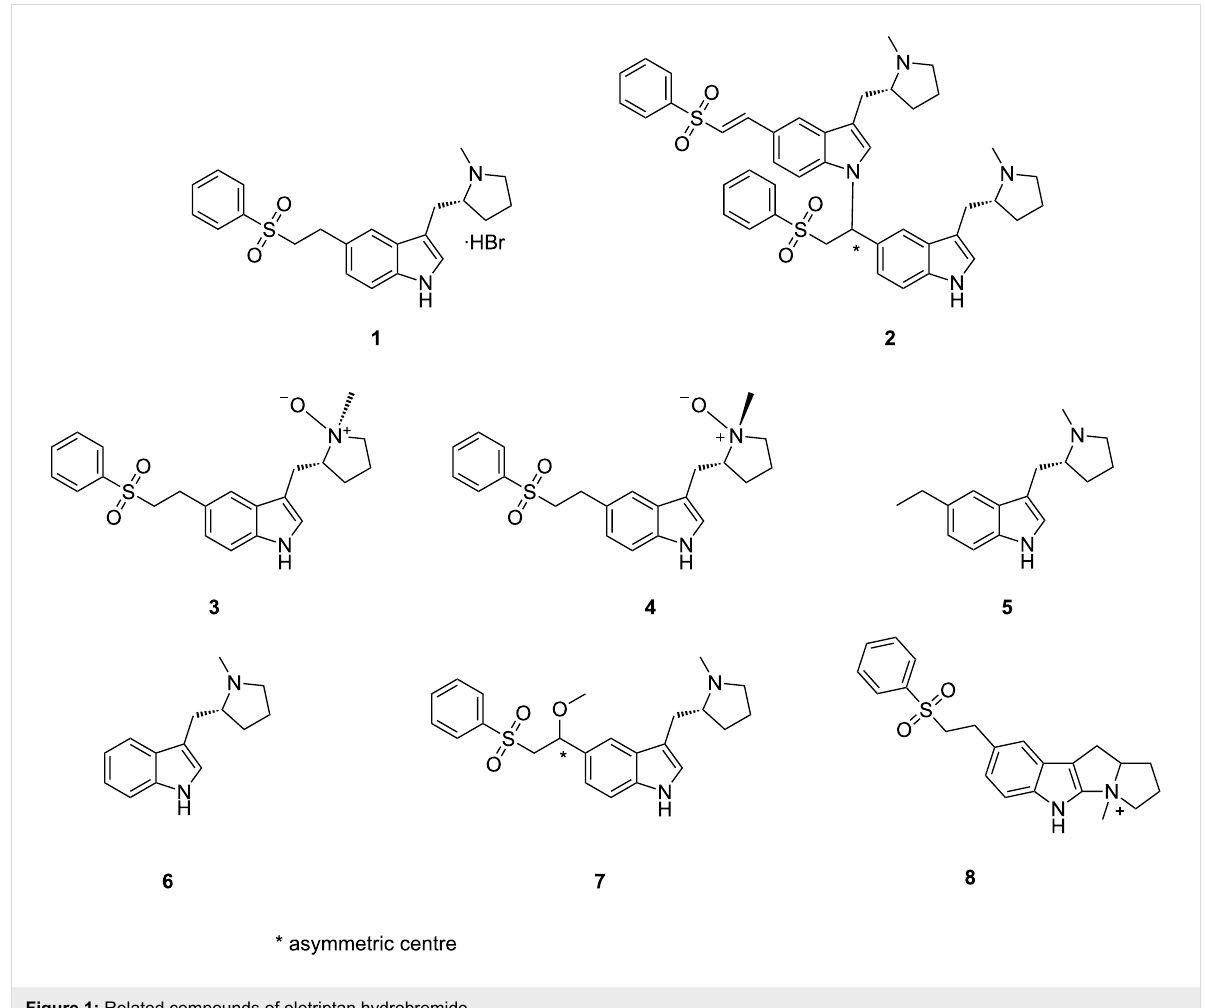
Figure 1: Related compounds of eletriptan hydrobromide.